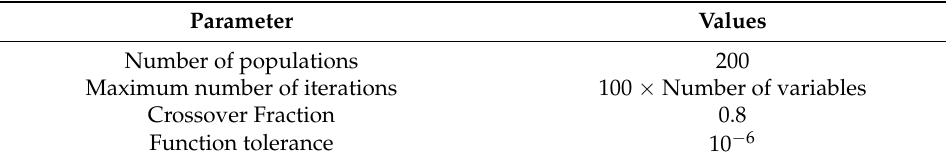
Figure 11. Schematic of optimization process using Aspen HYSYS and MATLAB. Table 4. Genetic algorithm parameter setting for system optimization.